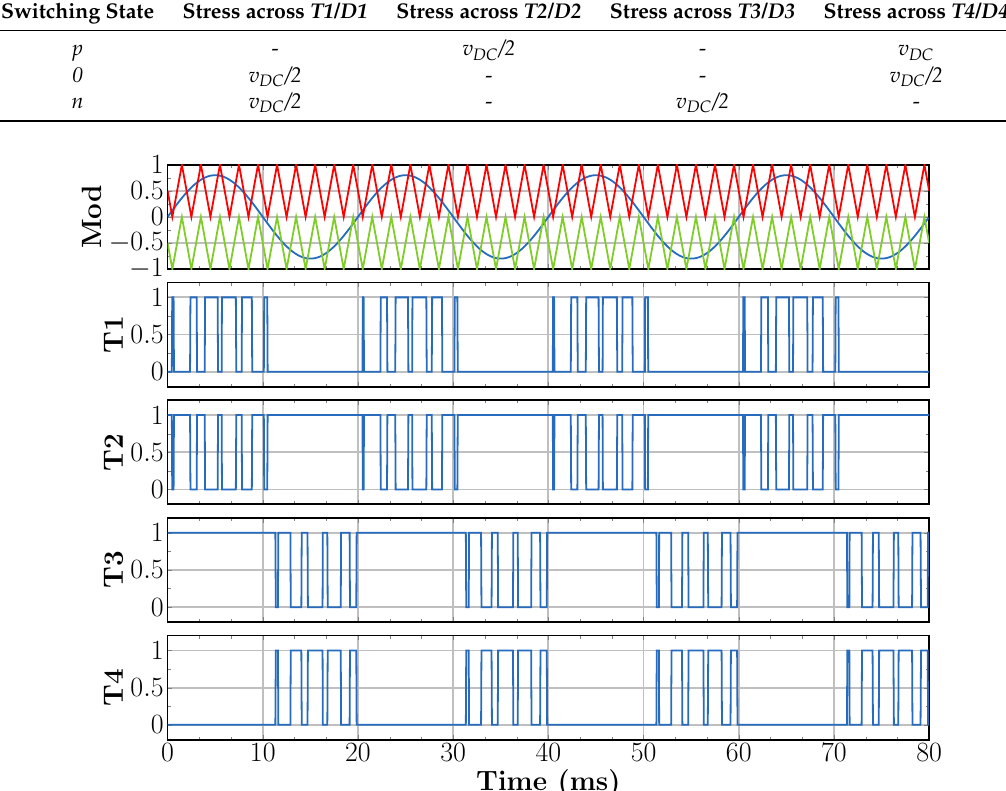
Figure 5. PWM generation waveforms. From top to bottom: reference voltage: modulation signal (blue), Triangular Carrier Signal 1 Vtri1 (red), and Triangular Carrier Signal 2 Vtri2 (green). Gating signal for switch T1 . Gating signal for switch T2 . Gating signal for switch T3 . Gating signal for switch T4 (Based on